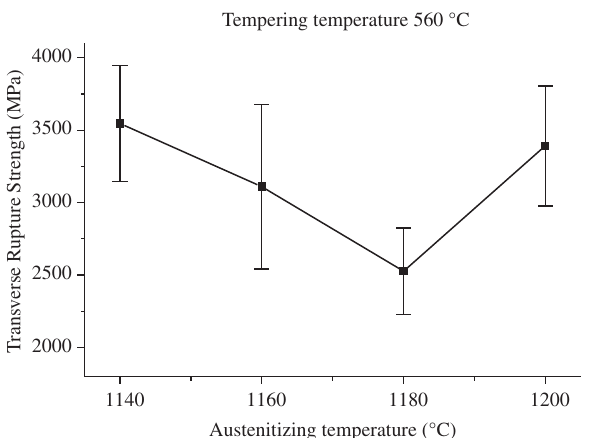
Figure 10. TRS as a function of austenitizing temperature (tempered at 560